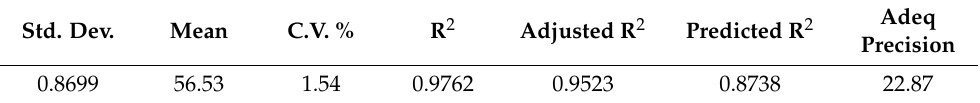
Table 9. Fit statistics of